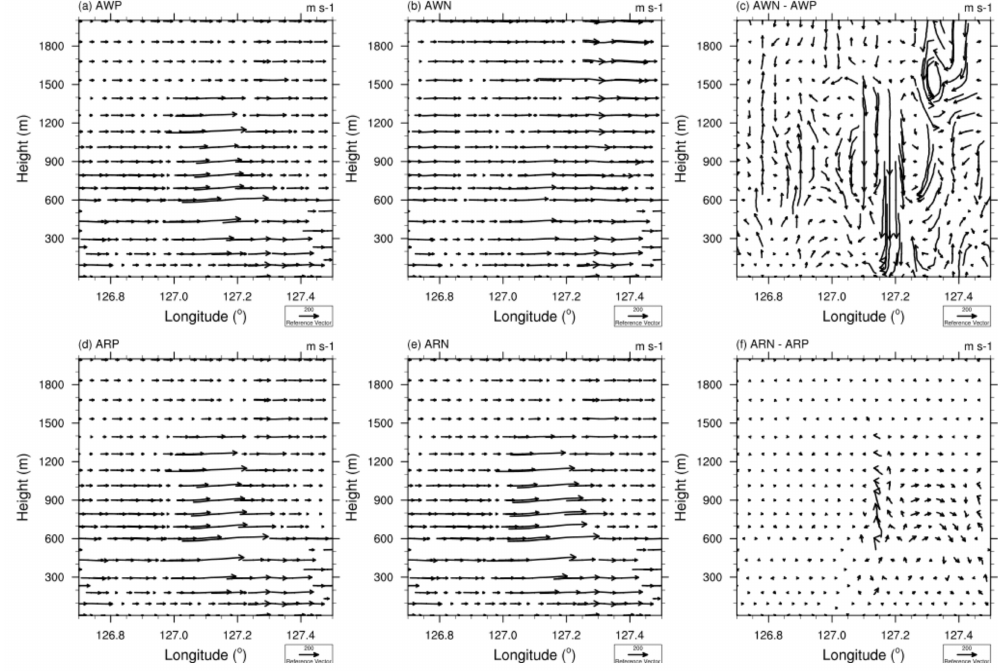
Figure 11. Vertical distribution of wind vector (m s − 1 , 3000 m s − 1 ) at 37.33 ◦ N in ( a ) AWP, ( b ) AWN, ( c ) AWN-AWP, ( d ) ARP, ( e ) ARN, and ( f )